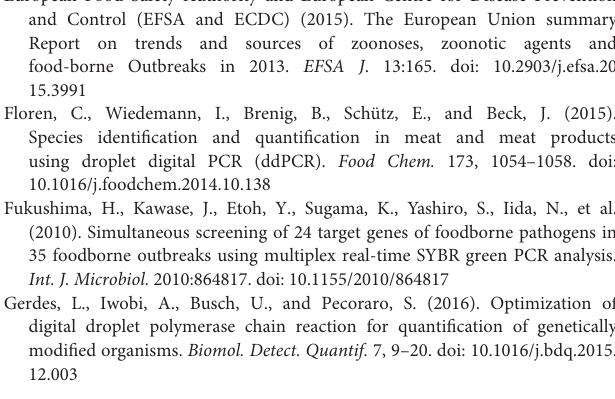
Supplementary Table 1 | Results obtained during the intra- and inter-assay repeatability. Supplementary Table 2 | dMIQE checklist for authors, reviewers and